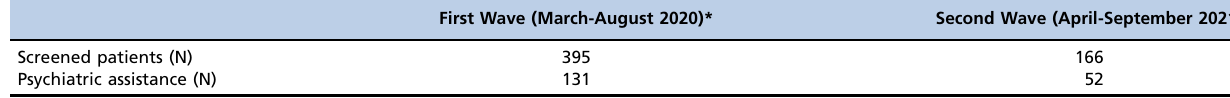
Table 1 - Number of HCWs assisted via the COMVC-19 program in the 1 st and 2 nd waves of the COVID-19 pandemic.